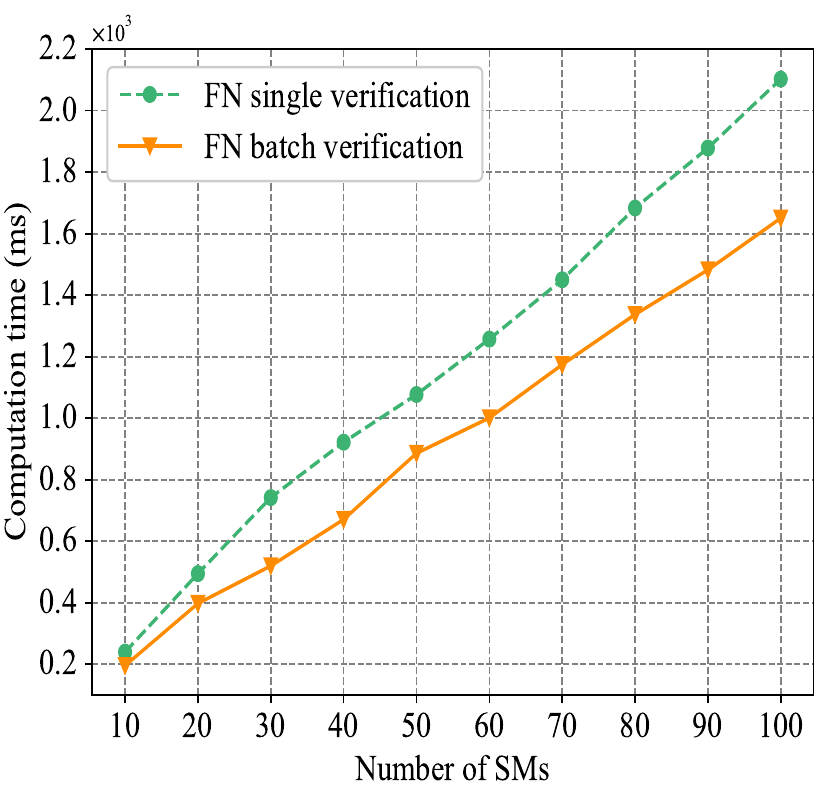
Figure 6. Comparison of computation time for batch verification and single verification by